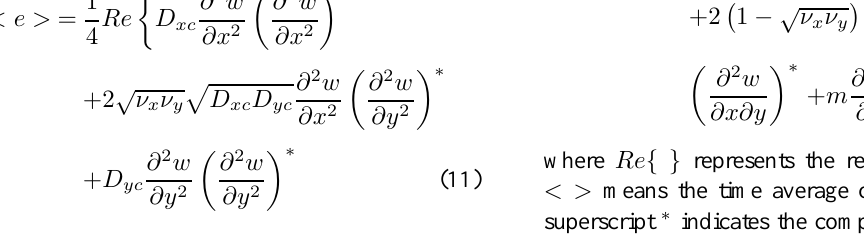
Fig. 8. The approximate energy density distribution of the orthotropic plate when f = 500 Hz and η = 0 . 2 . The reference energy density is 1 × 10 − 12 J/m 2 . 1 < e > = 4